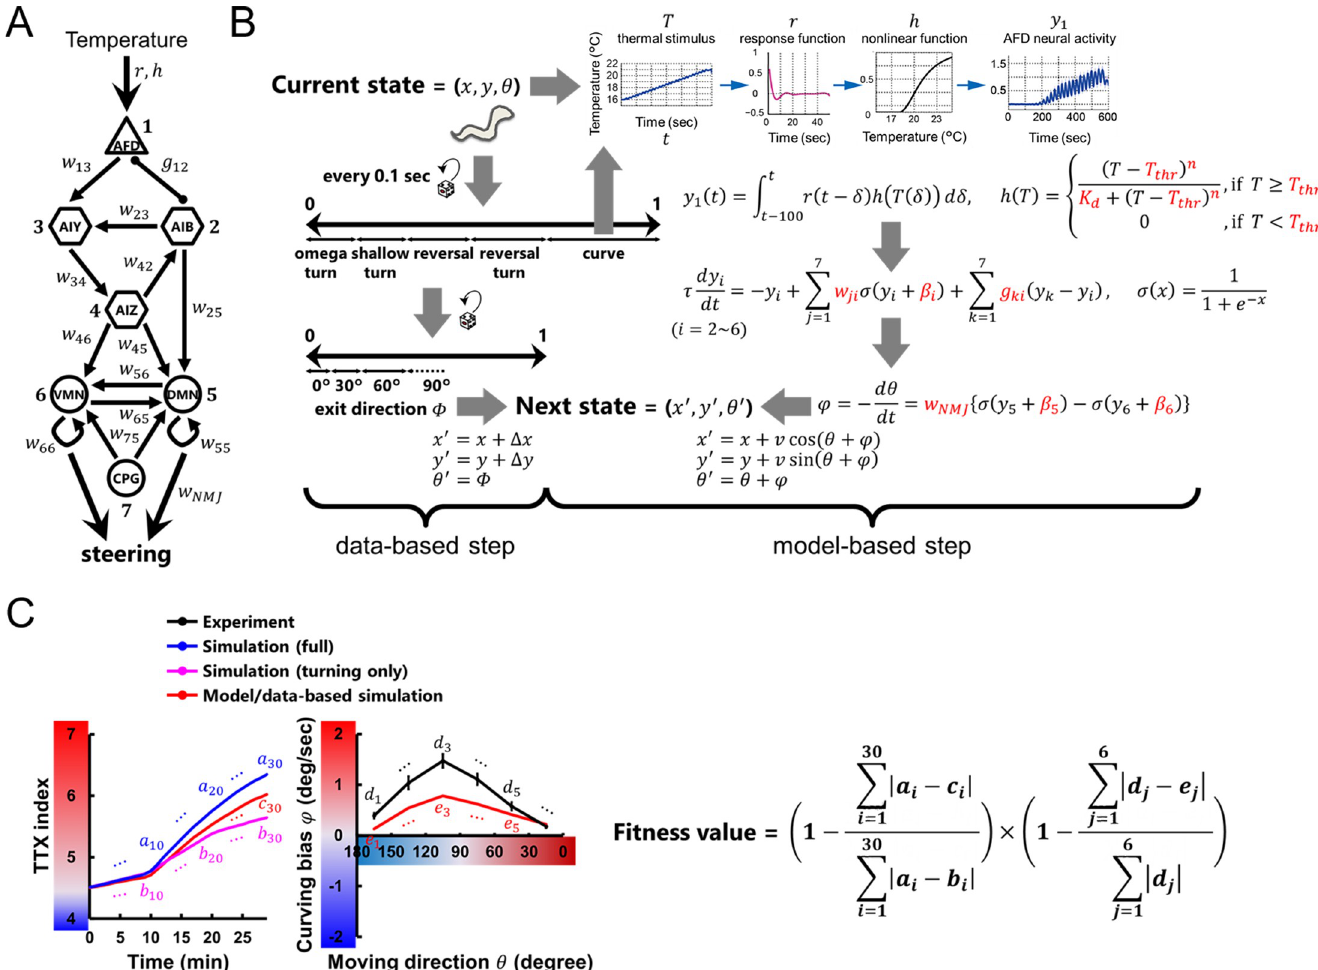
Fig 2. Thermotactic simulation for building a neuroanatomical model. (A) Neuroanatomical model that generates bias in steering behavior during positive thermotaxis [9], including thermosensory neurons (triangles), interneurons (hexagons), and head motor neurons (circles). Black thin arrows indicate chemical synapses, and black undirected lines with round endings gap junctions. An oscillatory component CPG is added to generate dorsoventral body undulation of C . elegans . (B) Schematic structure of the thermotactic simulation for searching parameters in the model with an evolution algorithm. Worm’s state was defined by its position ( x , y ) and moving direction ( θ ). We updated the states of the model worm every 0.1 second in two ways: according to the empirical data or via the neuroanatomical model for steering behavior. In the former case, frequencies, exit directions ( F ), and displacements ( Δ x , Δ y ) during turning were applied as functions of θ , temperature, and time. In the latter case, activity of AFD ( y 1 ) was estimated by empirically determined response property r [18], activity of inter- and motor ) were calculated with simple first order nonlinear dynamics [40], and the magnitude of curving biases ( φ ) was calculated proportionally to the difference neurons ( y 2 − 6 in activities of dorsal and ventral neck motor neurons ( y 5 and y 6 ). Red parameters in the equations were optimized in evolutionary searches (see Materials and Methods). (C) Formula for the fitness value in evolutionary searches. TTX index and curving bias from the model/data-based simulations (red lines) were subtracted from the index in the data-based simulations (blue line in left panel) or the bias in the experiment (black line in meddle panel), respectively. The differences were summed up, normalized, and multiplied with each other to generate a total fitness